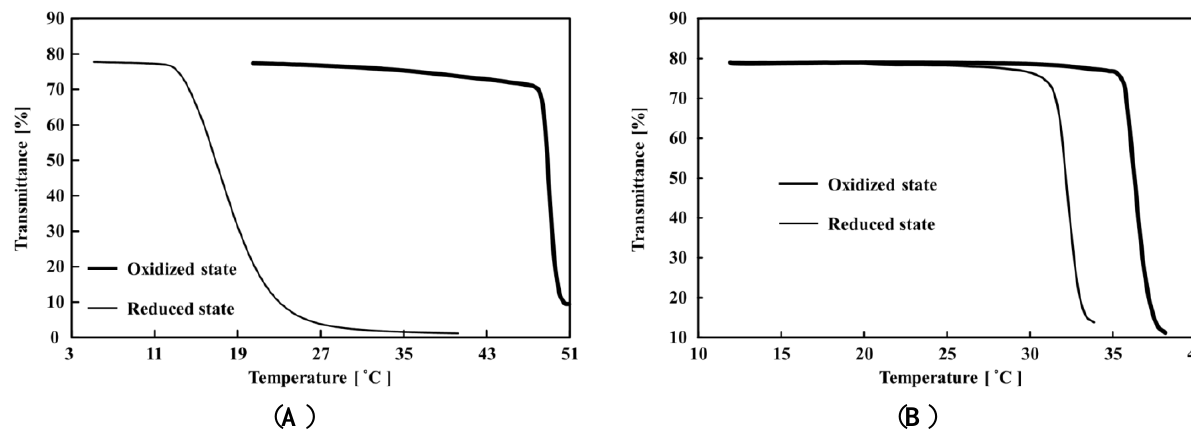
Figure 3. Relationship between transmittance and temperature for the poly(NIPAAm- co